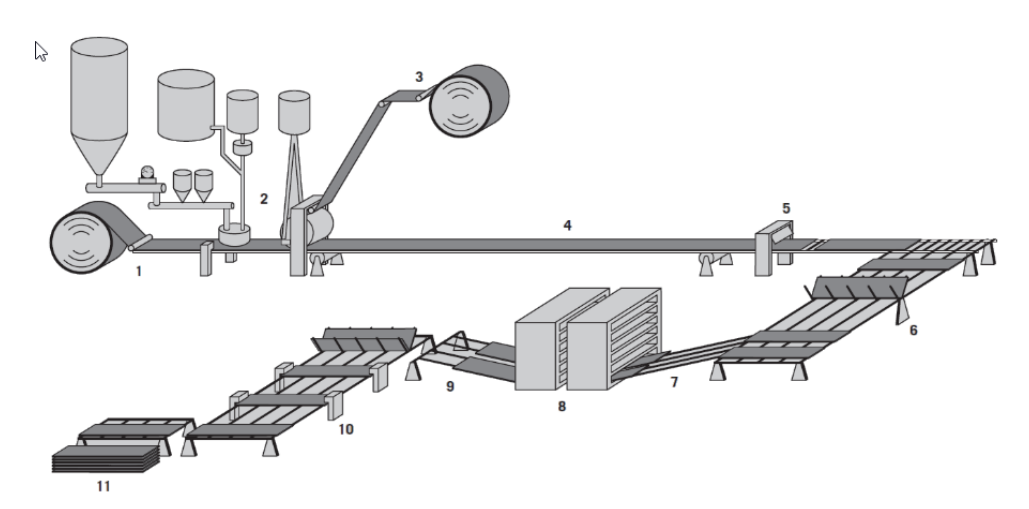
Figure 1. Schema of production of plasterboards.